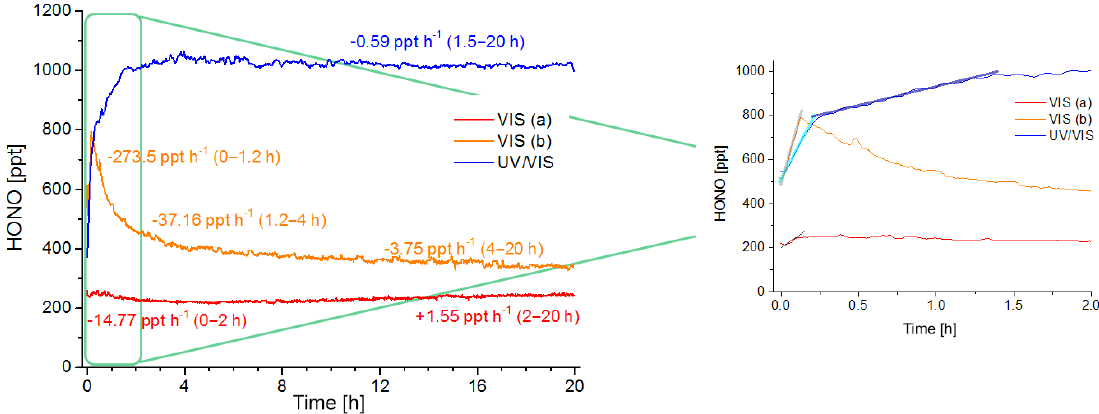
Figure 8. Extended measurements (20h) of light-enhanced HONO formation on BSA (three coatings of 17.5µgcm − 2 ) at 80% RH, 100ppb NO 2 . HONO formation under VIS light is shown in red and orange, under UV/VIS light in blue. HONO decay rates (ppth − 1 ) are shown with time periods (in brackets) in which they were calculated, suggesting a stable HONO formation after 4h. Right: magnification of the first 2h. Straight lines (black, grey, light and dark blue) show the slopes of which d[HONO] / d t were used in the kinetic